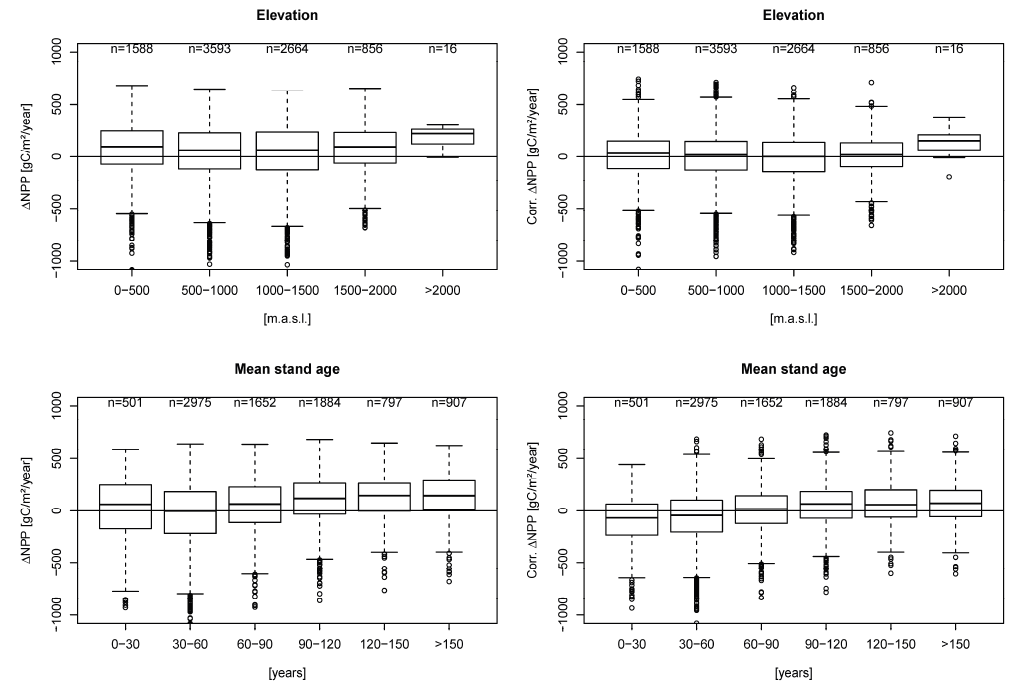
Figure 7. Difference between MODIS NPP and NFI NPP (MODIS minus NFI) grouped by elevation ( top ) and mean stand age ( bottom ). Left original MODIS NPP ( ∆ NPP) is used, right the detrended MODIS NPP (Corr. ∆ NPP) is used. Properties of illustration analogous to Figure